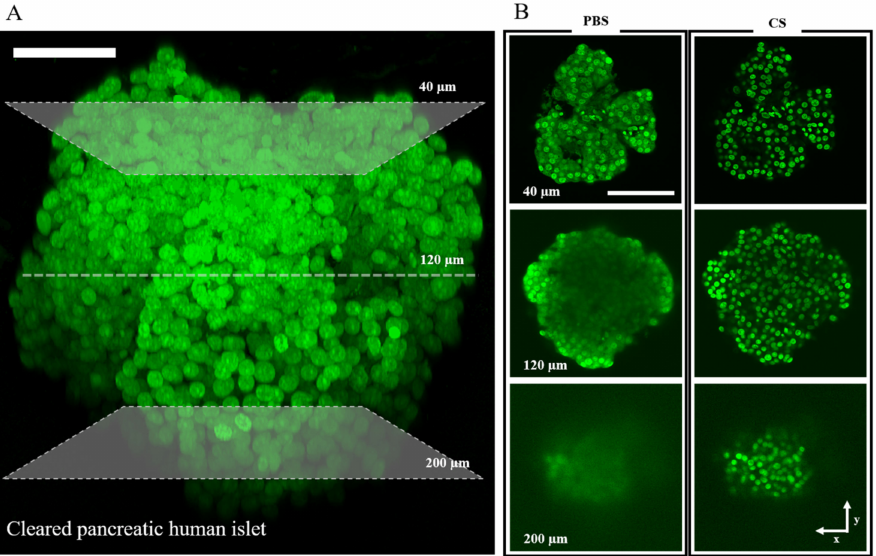
Figure 10. Clearing procedure applied on intact Langerhans islet. ( A ) 3D reconstruction of pancreatic islet labeled with DAPI using two-photon excitation microscopy combined with the clearing pro- cedure (Exc. 800 nm; scale bar 50 µ m). ( B ) XY images at different depths (40, 120, and 200 µ m) in normal (PBS) and cleared sample (CS). After fixation with paraformaldehyde, the specimens were labeled with DAPI and then incubated with a solution consisting of a mixture of 2,2 (cid:48) -Thiodiethanol (TDE) and PBS. The ability of TDE to decrease the refractive index by dehydration allows reduction of the light scattering process, and performing whole-human islet imaging of cells (Exc. 800 nm; scale bar 100 µ